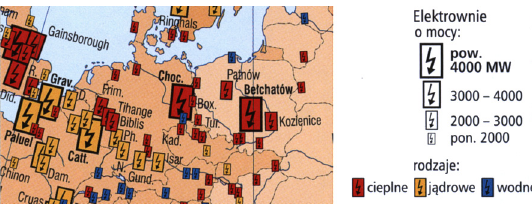
Fig. 6. “Quantitative signature symbols” used to show the power of thermal, nuclear, and hydroelectric plants